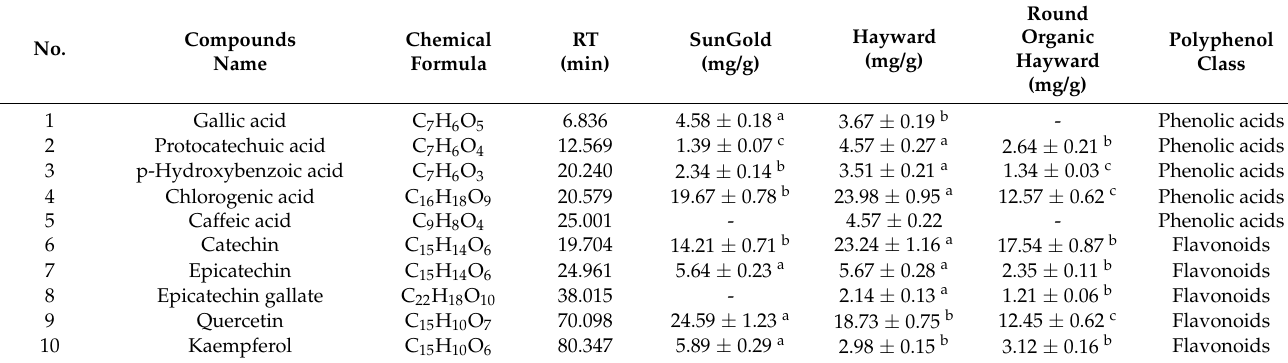
Table 3. Quantitative analysis of phenolic compounds in